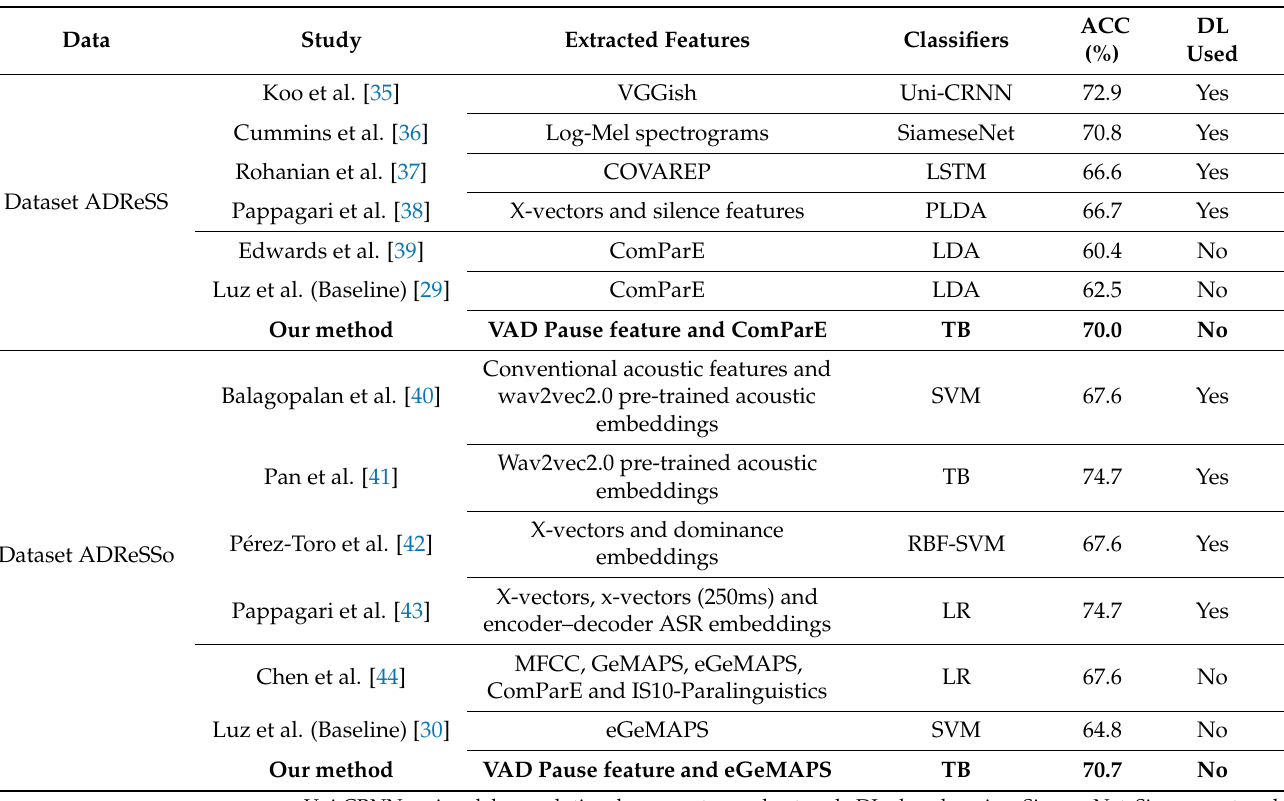
Table 3. Accuracy (ACC) comparison of the ensemble method with other approaches, using only acoustic features on the test sets in the